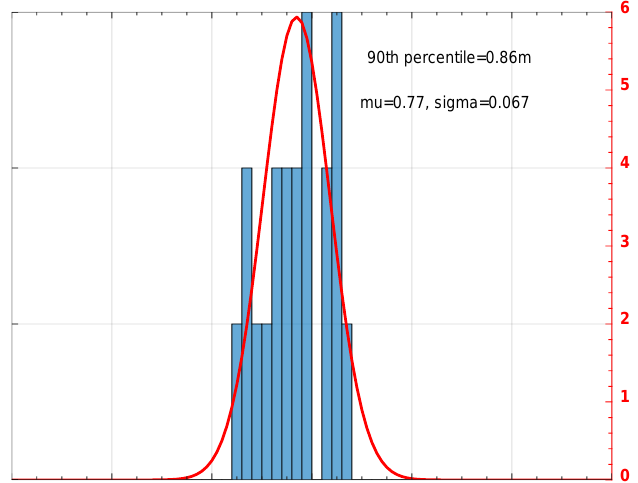
Figure 17. Displacement of the auxiliary building under BDBE ground motion response spectra (GMRS) (PGA = 1.0 g).